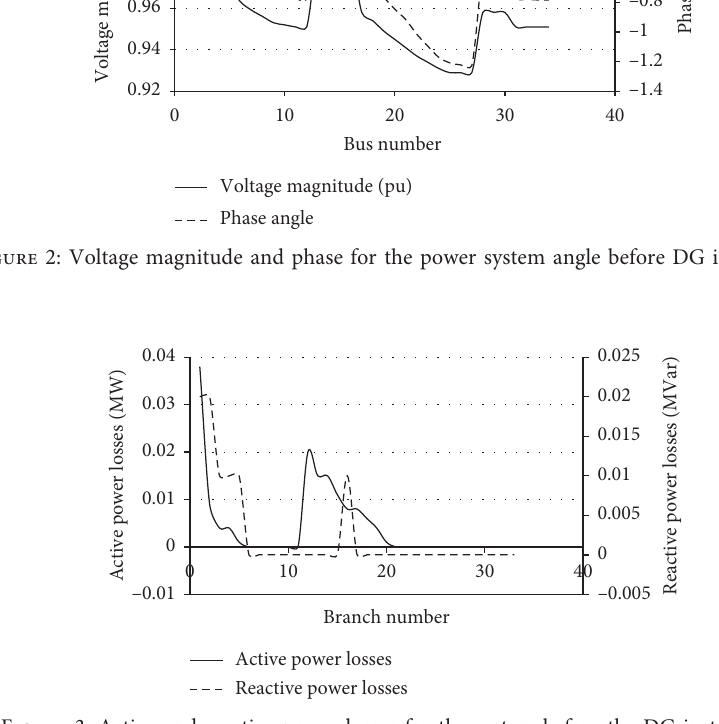
Figure 3: Active and reactive power losses for the system before the DG installation.